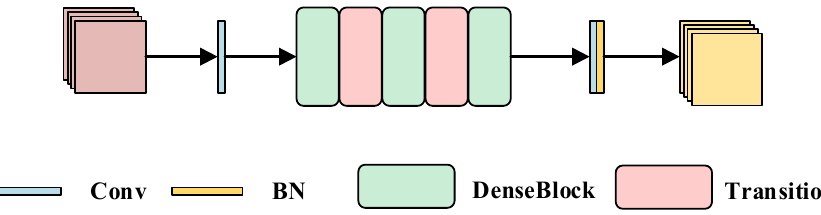
Figure 3. The framework of improved DenseNet.